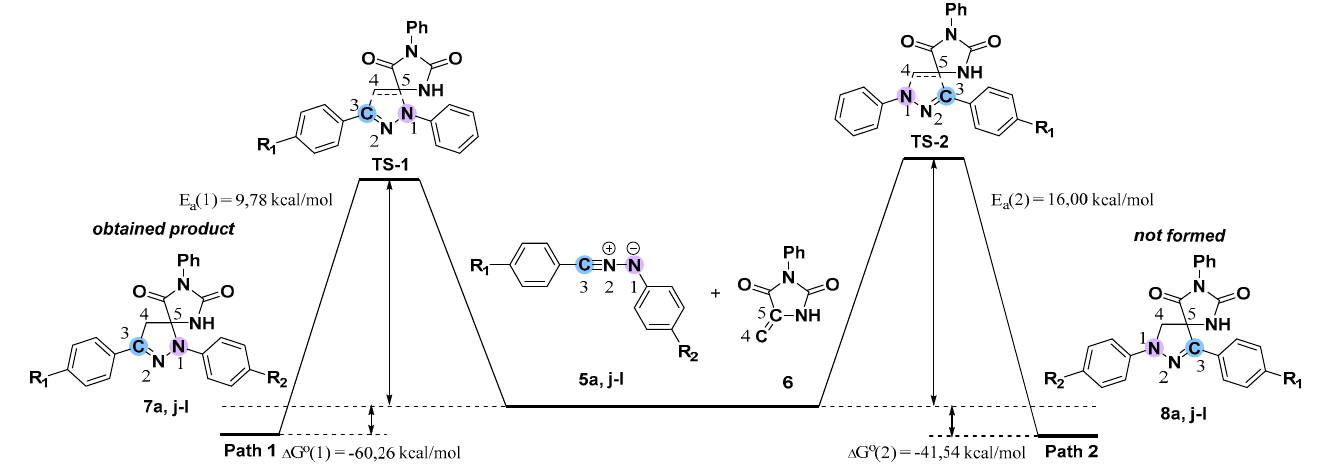
Scheme 5. Schematic representation of minimum energy paths (MEP) corresponding to the studied 1,3-dipolar cycloaddition reaction in two pathways. Table 4. Calculated Fukui functions and local electrophilicity ( ω k ) and nucleophilicity (N k ) at the reactive sites of nitrile imines 5a , j-l , and 5-methylidenehydantoin 6